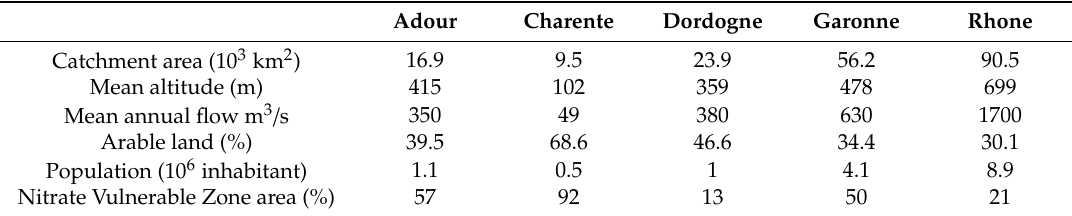
Table 2. Characteristics of the studied river basins (retrieved from French Ministry of Environment [20] and Tockner et al.,